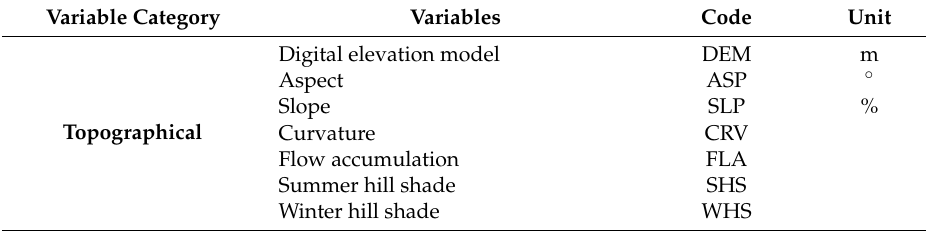
Table 2. List of the 27 ecogeographical variables (EGVs) used to model indigenous and non-indigenous woody